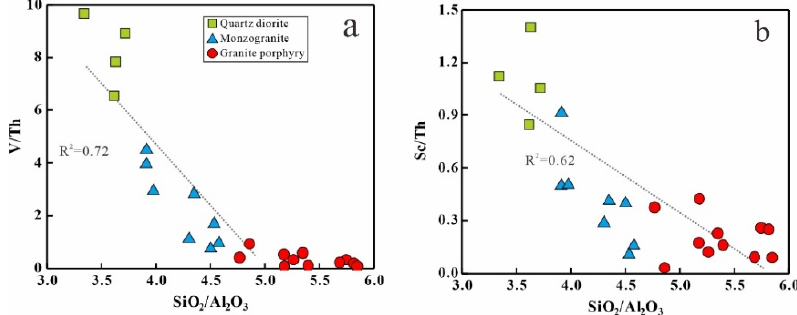
/ Al / Th ( a ) and Sc / Th ( b ) for the granitoids from Figure 9. SiO 2 /Al 2 O 3 versus V/Th ( a ) and Sc/Th ( b ) for the granitoids from Zalute. Figure 9. SiO 2 2 O 3 versus V